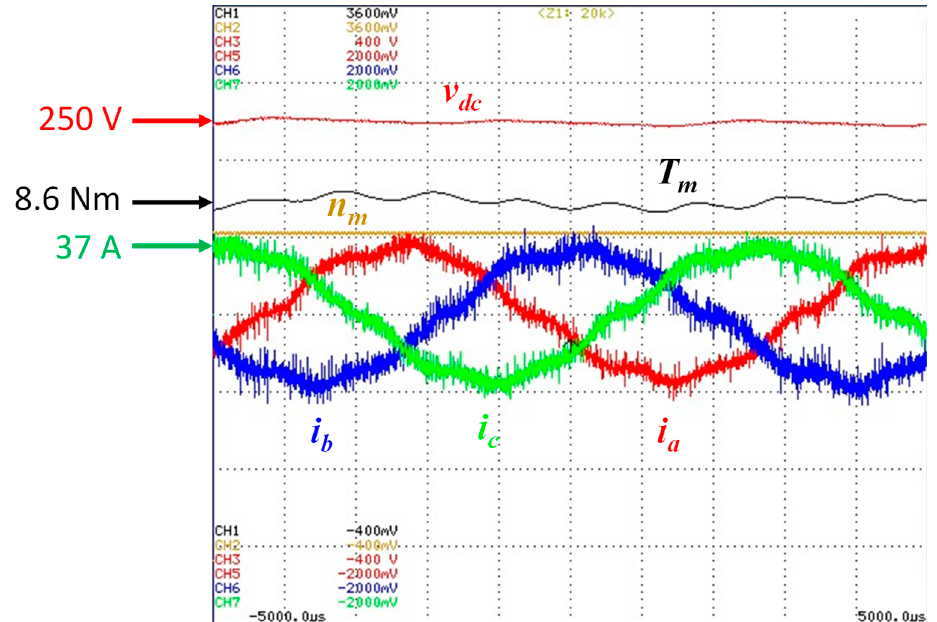
Figure 13. Experimental results of the traction system operating at a constant speed (2000 rpm) with an 8 Nm load: the torque ( T m ) and speed ( n m ) of the SRPM machine; dc-link voltage ( v dc ); stator windings’ currents ( i a , i b , i c ).